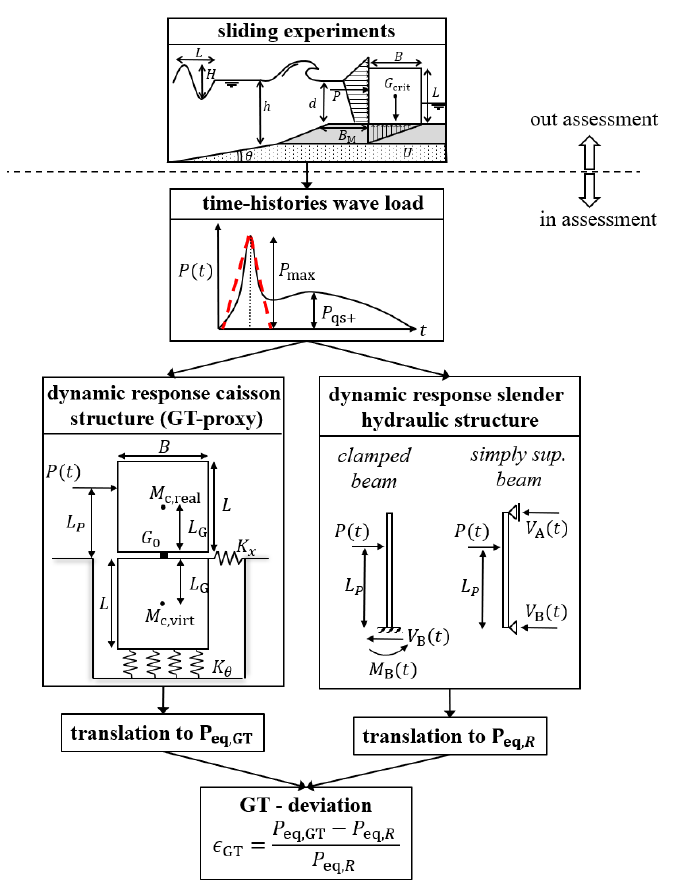
Figure 8. Methodology adopted in this study for the determination of the Goda–Takahashi wave load formula